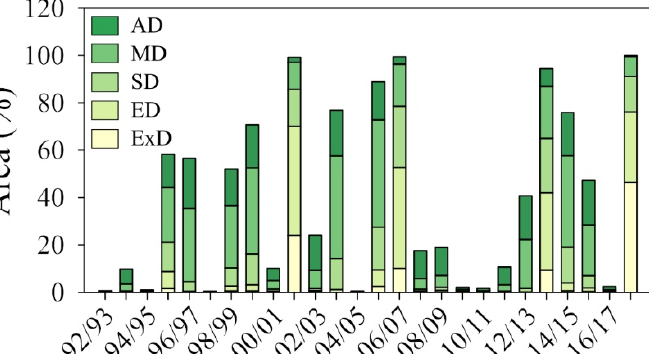
Figure 7. Drought classification and affected areas identified with the Modified Soil Adjusted Vegetation Index standardized predicted values in the intervening season 2 (IS2) at the Guadalupe Valley Basin, Baja California, Mexico (AD–abnormally dry; MD–moderate drought; SD–severe drought; ED–extreme drought; ExD–exceptional drought). The x-axis indicates the hydrological year.